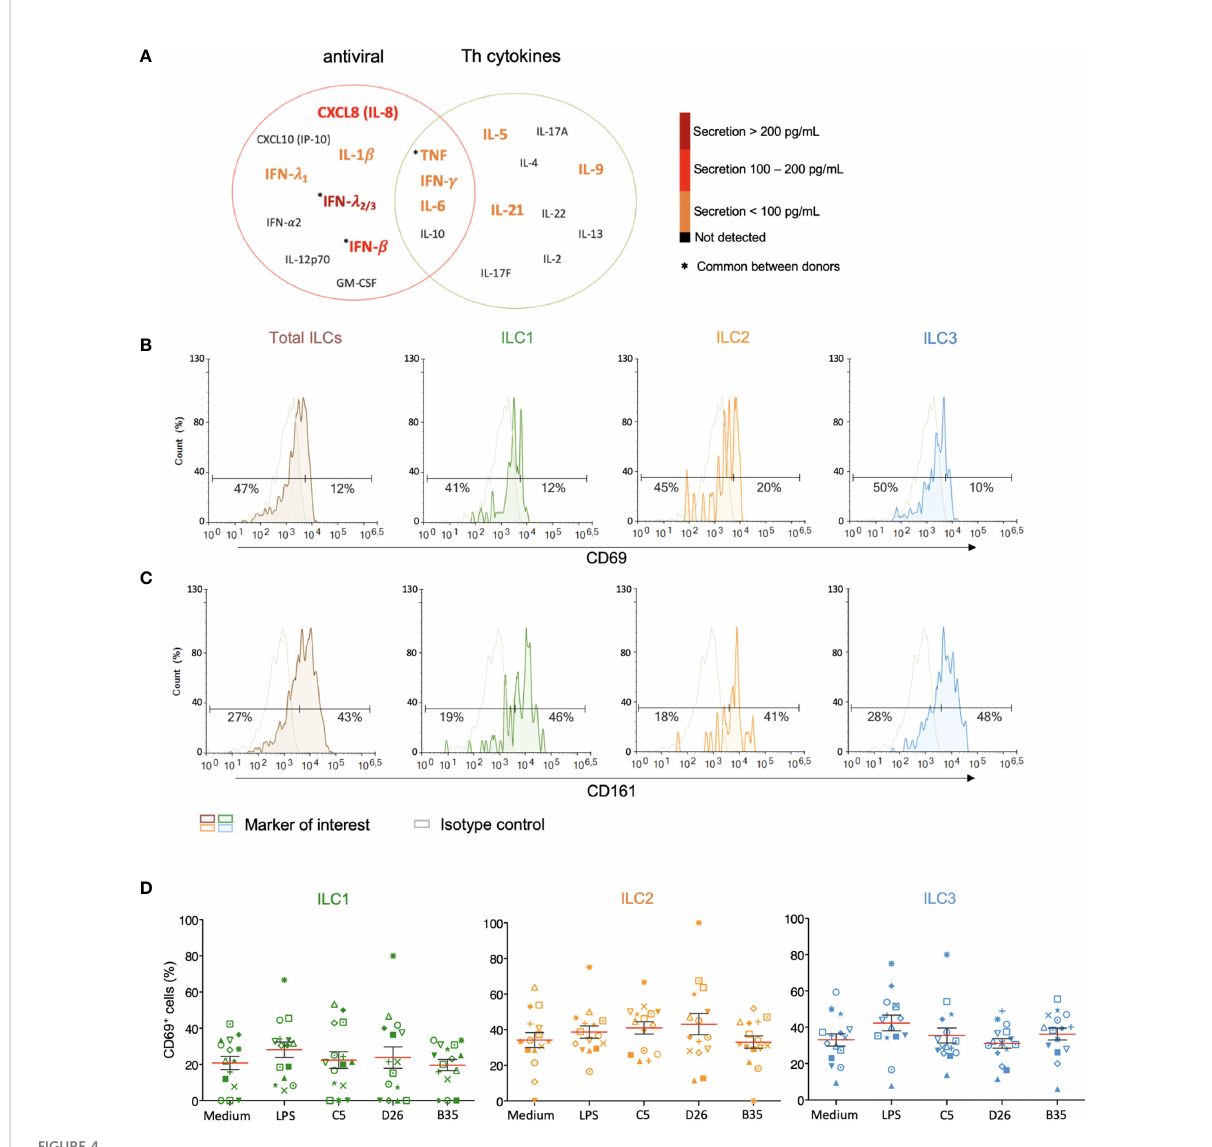
FIGURE 4 Cytokine release and phenotypic pro fi le of ILCs after HAdV uptake. (A) Cytokines belonging to an antiviral panel or a Th screen were quanti fi ed from the supernatant of HAdV-challenged ILCs by CBA (n = 5). Cytokine levels are denoted by the colour code and the results were analyzed with the LegendPlex ™ software. Only the cytokines whose levels were at least 2-fold higher than that of the controls are shown. Baseline levels of (B) CD69 and (C) CD161 in freshly isolated total ILCs, ILC1, ILC2 and ILC3 (n > 26). Cell populations were normalised to 100% (n ≥ 5); (D) CD69 levels ± SEM in ILC1, ILC2 and ILC3 post challenge with HAd-C5, -D26, or B35 (n = 15). * represents a individual donor